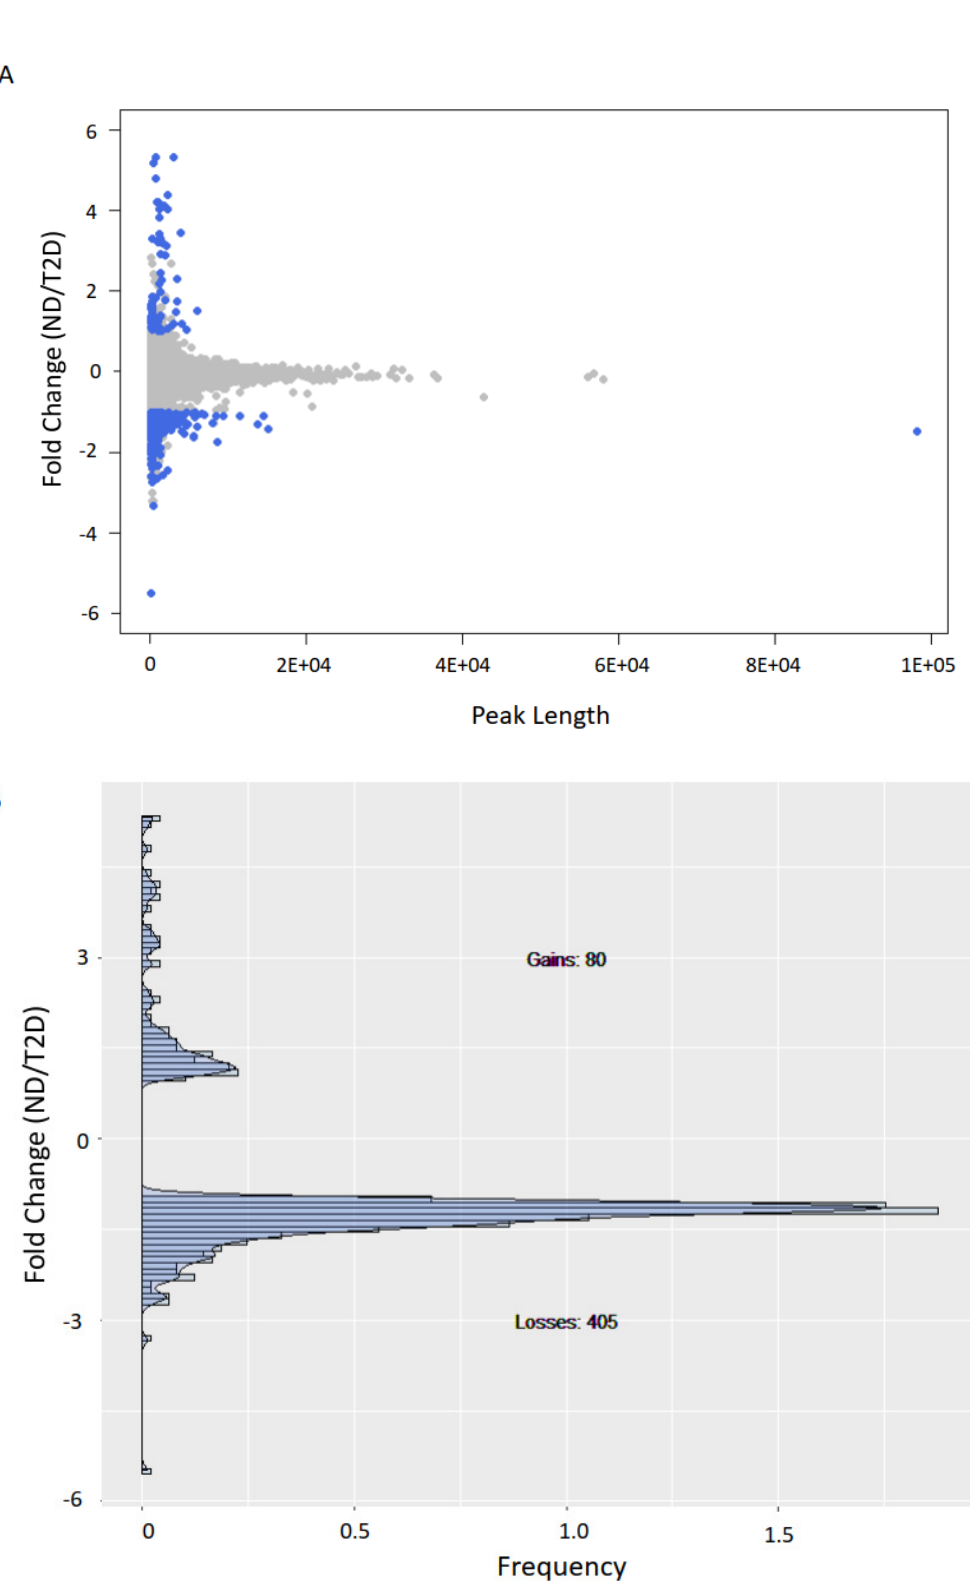
Figure 2. H3K9ac is predominantly lost in T2D. ( A ) Scatter plot of H3K9ac fold-change vs. peak size average (measured as area under the curve or AUC) for ND vs. T2D. ( B ) Histogram of H3K9ac fold-change vs. frequency for peaks with significant ( p < 0.05, Welch’s t test, two-sided) H3K9ac changes (blue dots in ( A